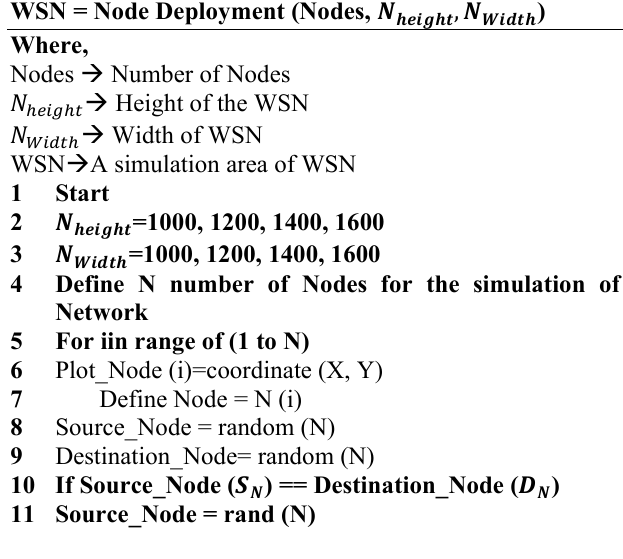
Algorithm 1: Node